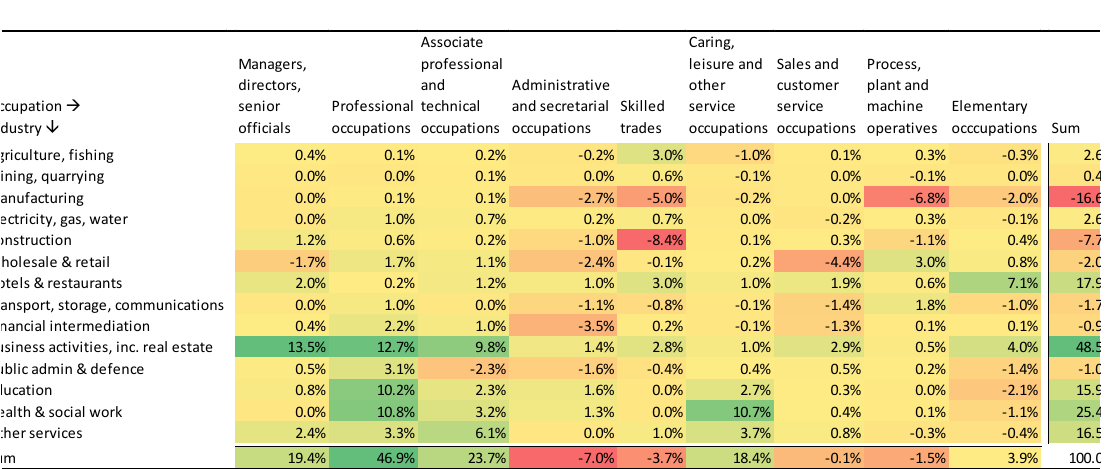
Table 3: Change in employment by occupation and industry: 2008-18